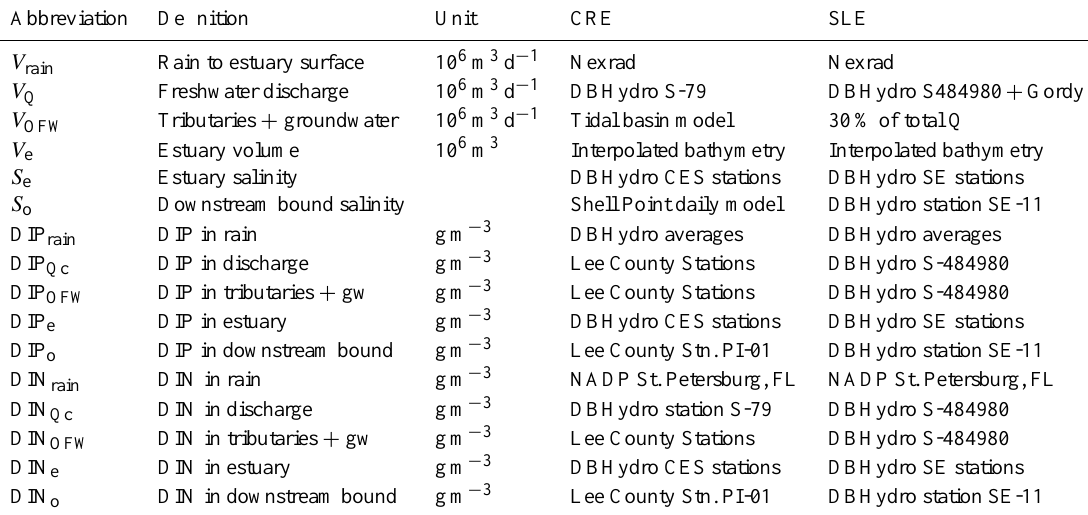
Table 1. Sources of input data for seasonal DIN and DIP budgets for CRE and SLE. Please see Sect. 2.2 for explanation and details and Figs. 1 and 2 for water quantity and quality monitoring